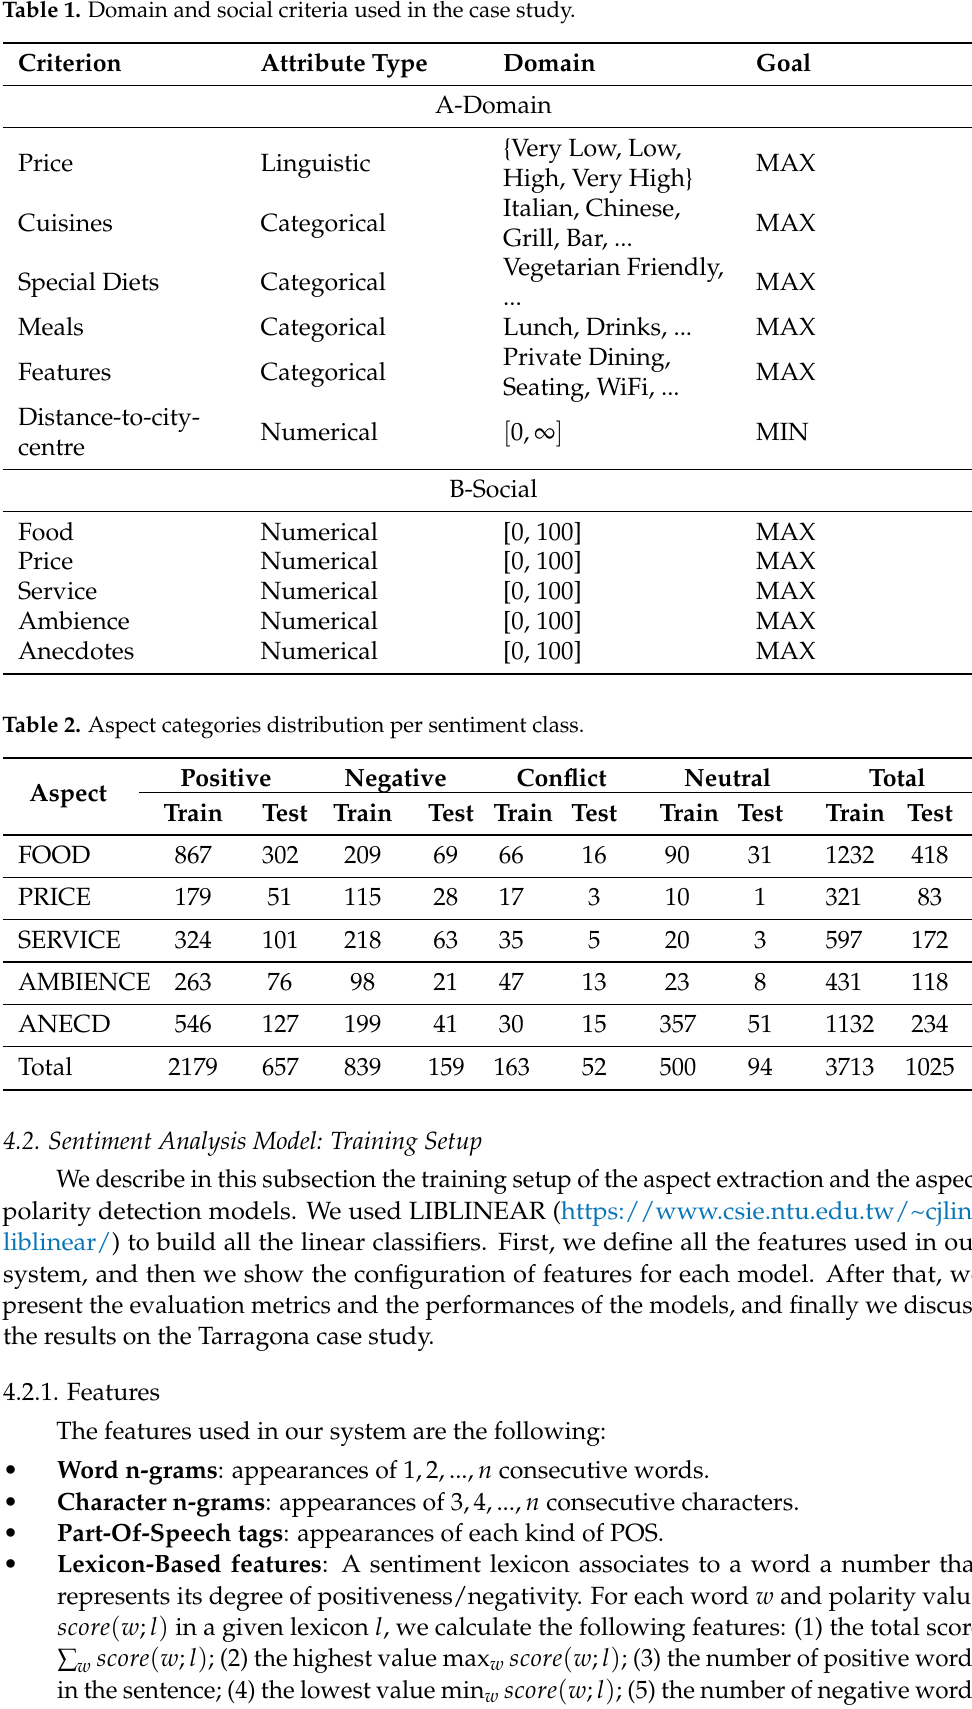
Table 1. Domain and social criteria used in the case study.